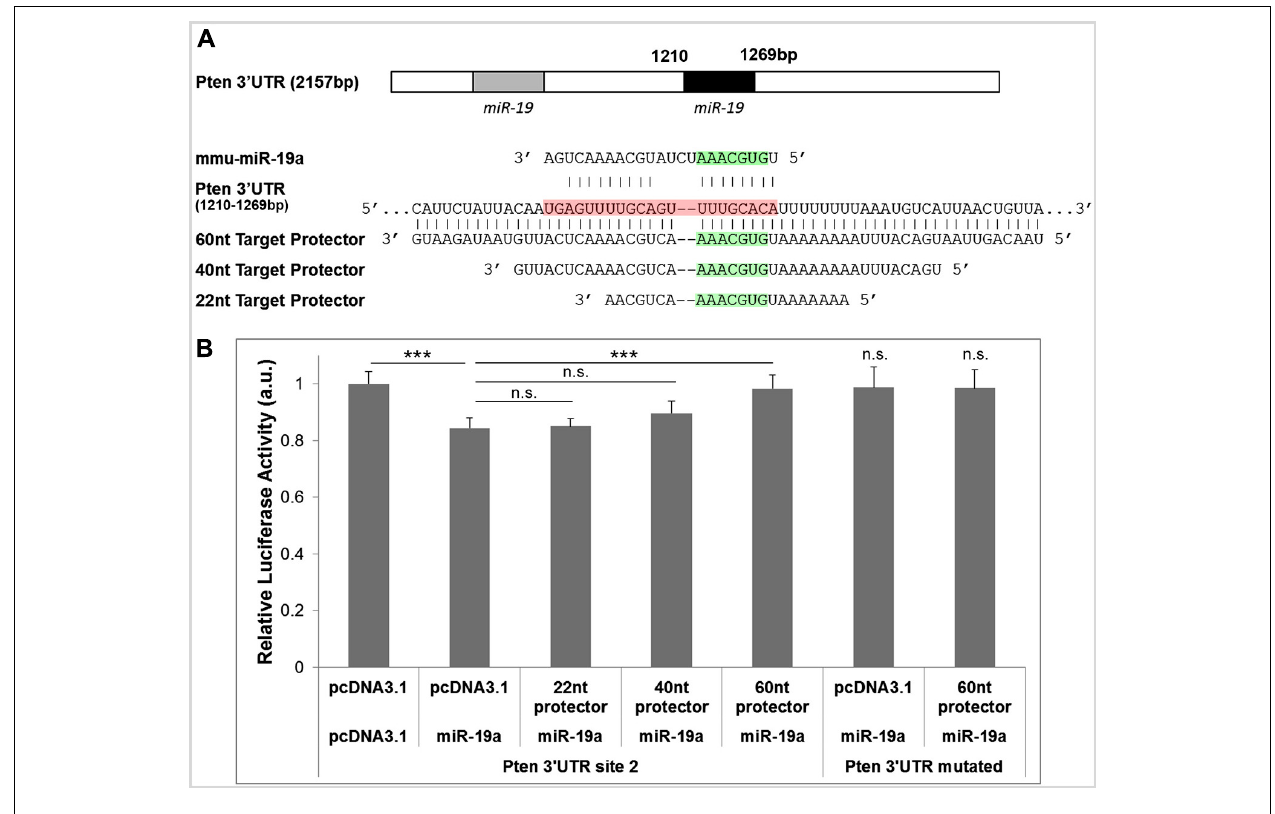
FIGURE 2 |Target protectors for Pten block miR-19a-induced repression. (A) Binding sites of miR-19a in the Pten 3 (cid:2) UTR and complementary target protector sequences for the second miR-19a binding site. The seed binding sequence of miR-19a is highlighted in green, and the entire length of miR-19a along the Pten 3 (cid:2) UTR is highlighted in red. (B) Luciferase assays of target protector effects on miR-19a repression of the second miR-19a binding site in the Pten 3 (cid:2) UTR. miR-19a reduced luciferase activity in the